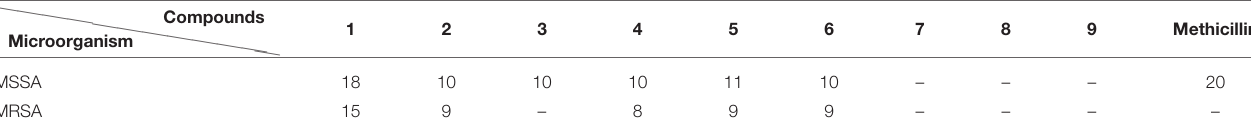
TABLE 5 | Inhibition zone (mm) growth of methicillin-sensitive Staphylococcus aureus (MSSA) and methicillin-resistant S. aureus (MRSA) of compounds 1 – 9 (100 µ g/disk). hhhhhhhhhhhh Compounds Microorganism